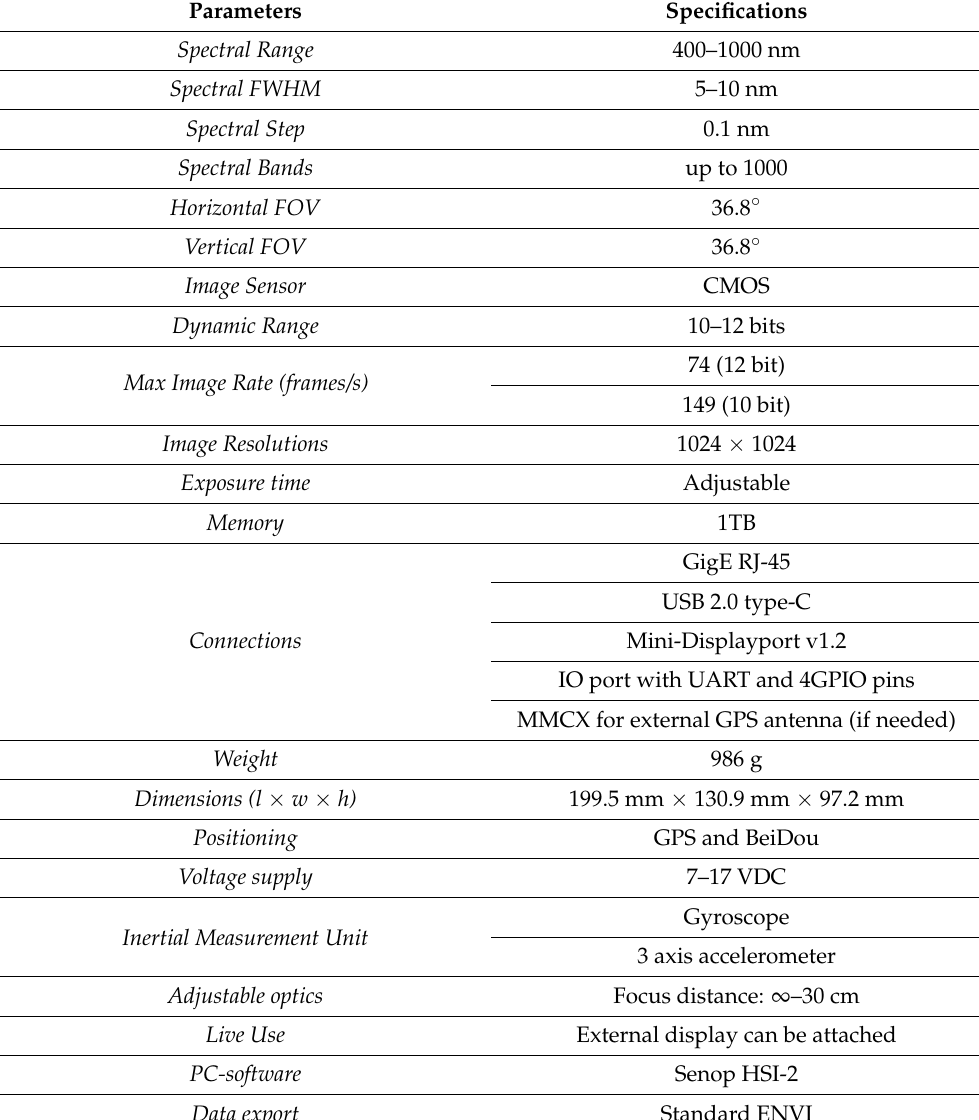
Table 2. Technical description of the HSI system